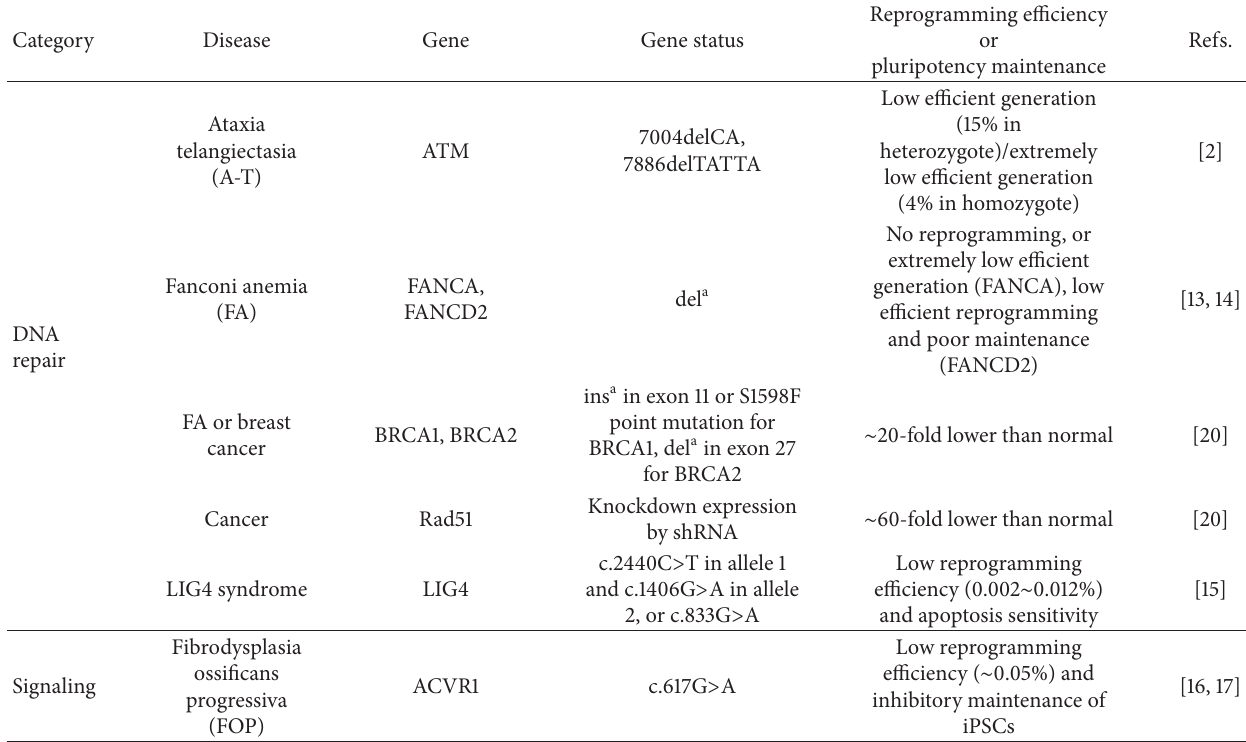
Table 1: Diseases with the inefficient reprogramming or inhibitory pluripotency